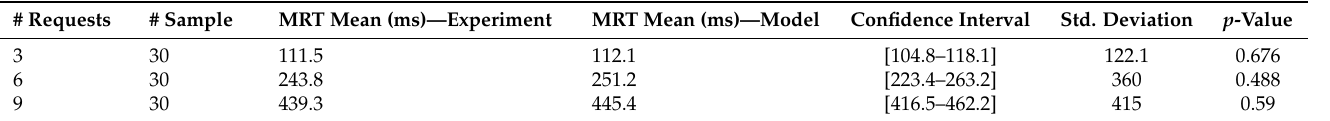
Table 4. Validation